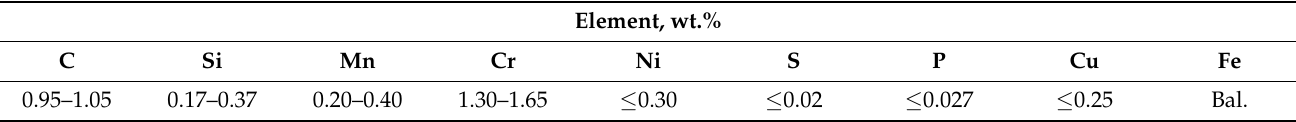
Table 1. Chemical composition of the counterbody steel. Element,